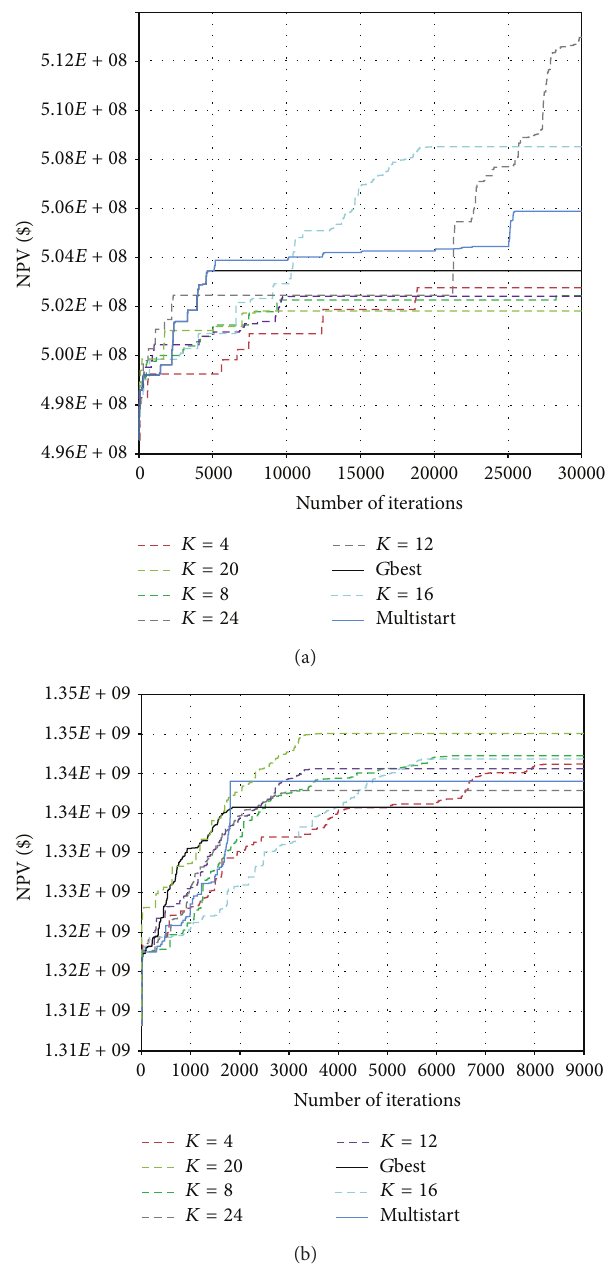
Figure 6: Convergence behaviour of the different variants of the PSO algorithm during a single run when applied to problem 1 (a) and problem 2 (b).